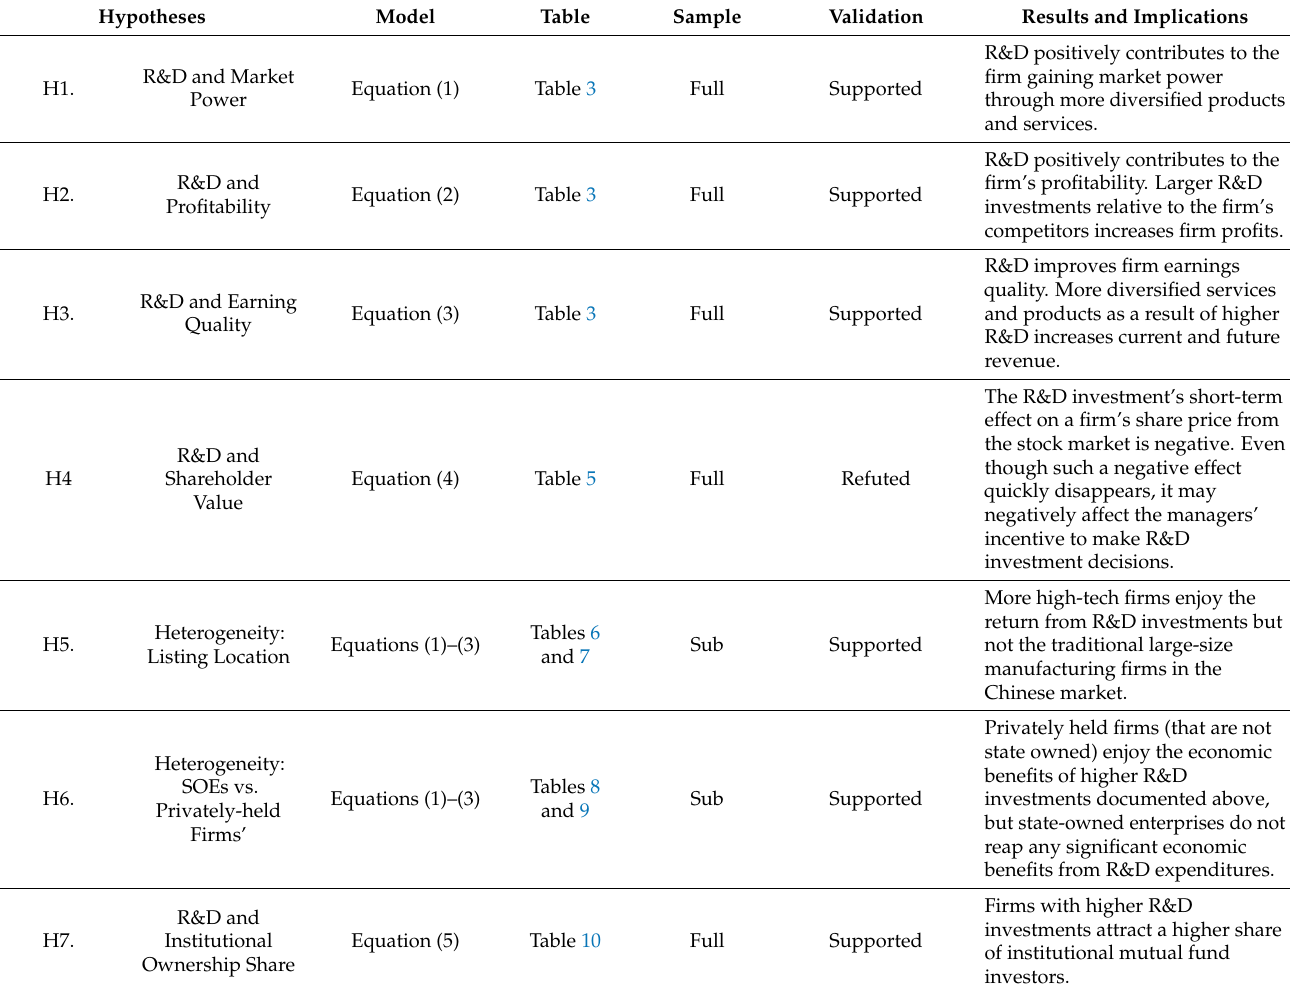
Table 11. Summary of findings and